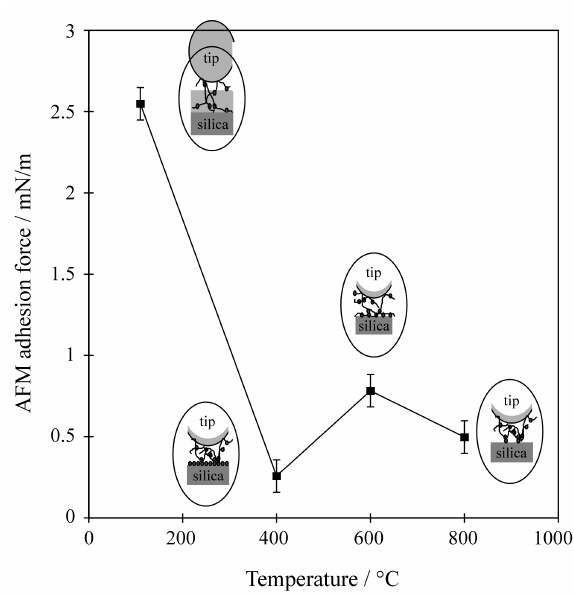
Figure 9. Effect of the temperature of heat treatment of silica surfaces on the AFM adhesion of a sulfonated polysulfone tip. Drawings represent the mechanisms used to explain the results ( filled circles = OH